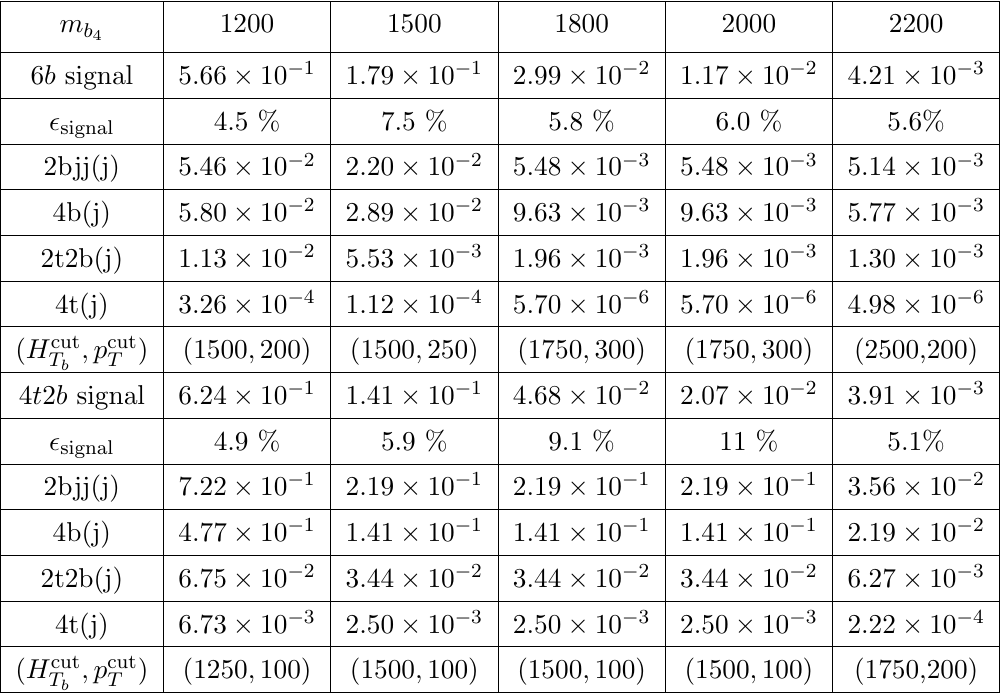
Table 1 . Signals pp b 4 b 4 b 4 b 4 6 b , pp 4 t 2 b and background (cid:12)ducial cross sections in ! ! ! ! units of fb in the 4b analysis. For each b 4 mass hypothesis, the optimized cuts are listed in the last row for integrated luminosity L = 3 ab (cid:0) 1 . The signal e(cid:14)ciency of the cuts ( (cid:15) ) is also presented. All results are presented using the 1b/2b-tagging working point ( (cid:15) 1 b ; (cid:22) (cid:15) 2 b ) = (0 : 8 ; 1 = 3).